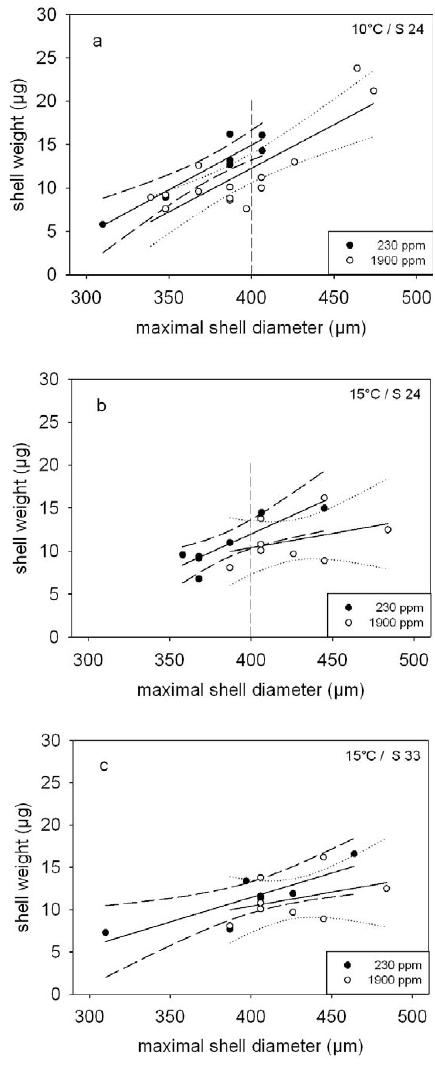
Figure 3 Fig. 3. Weight (µg) versus size (µm) of foraminifera grown under 3 230ppmv (closed circles) and 1900ppmv (open circles), at 10 ◦ C, salinity 24 (a) , at 15 ◦ C, salinity 24 (b) , and at 15 ◦ C, salinity 33 (c) . Data for 10 ◦ C and salinity 33 not available. Full lines repre- sent linear regression for each experimental condition. Dashed lines indicate the corresponding 95% confidence interval for the regres-